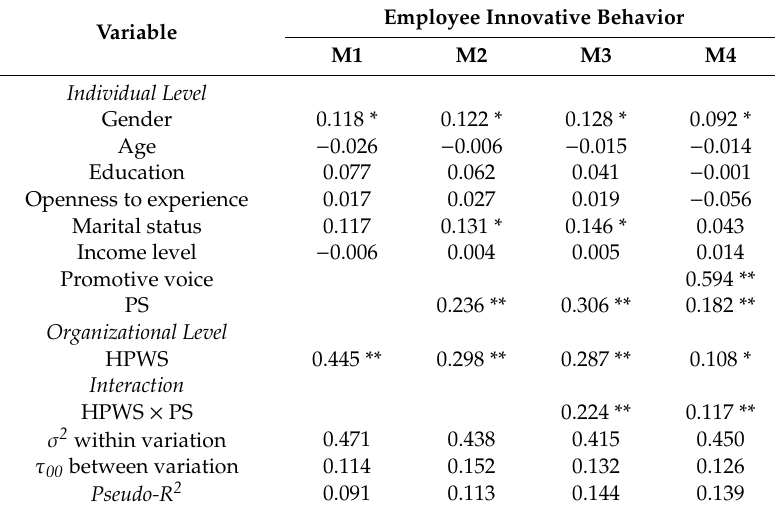
Figure 2. The interactive effect of HPWS and PS on promotive voice. Table 4. Test results of Hypothesis 7 (HLM).